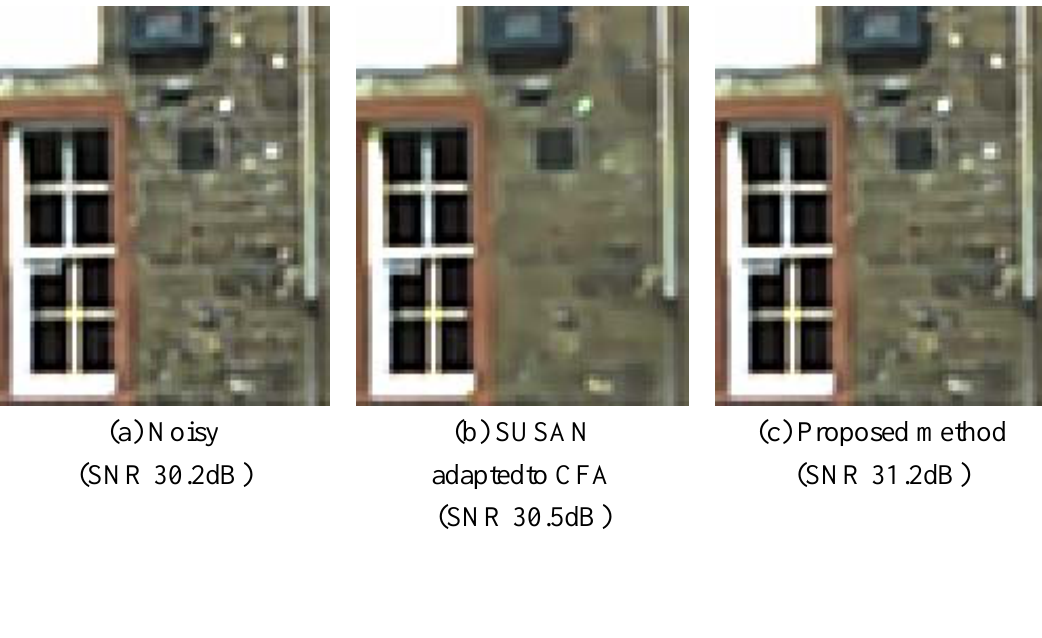
Figure 16. Comparison test at CFA level (magnified details of Figure 14(a)). The original SUSAN implementation was slightly modified so that it can process Bayer data. The efficiency of the proposed method in retaining image sharpness and texture is clearly